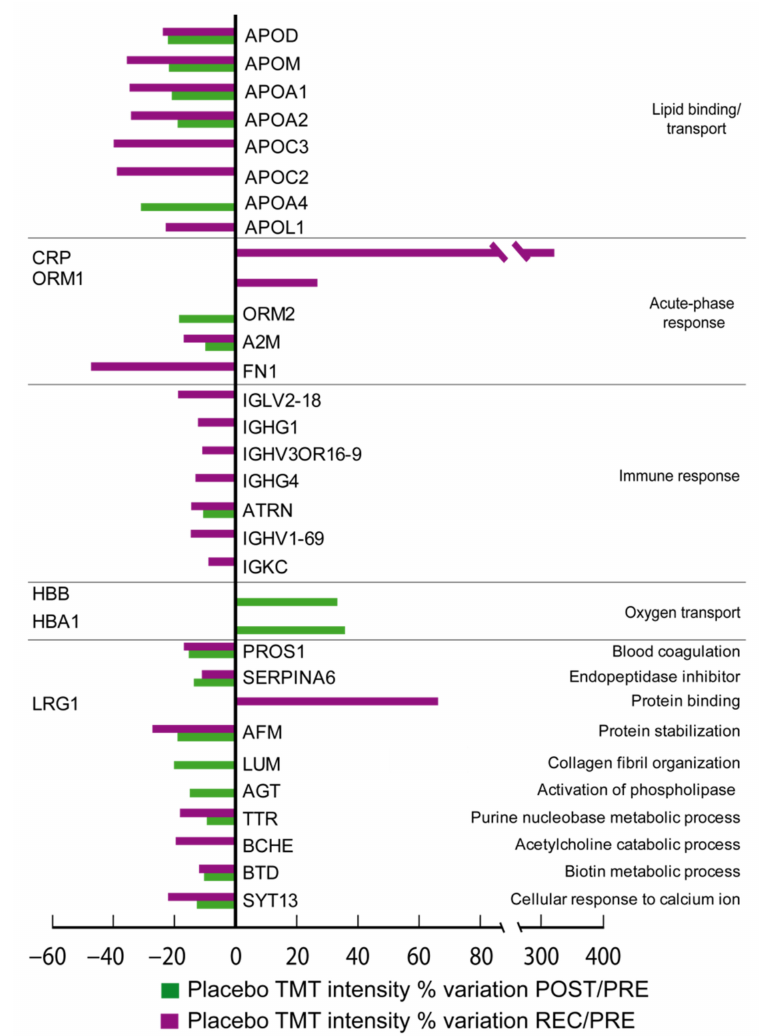
Figure 2. TMT LC-MS/MS proteomic analysis results from sera sample of placebo-treated BR group. Differential abundant proteins are expressed as histograms representing their intensity as a percentage of variation from PRE. Green bars represent variation identified in the POST/PRE, while purple bars represent alterations identified in the REC/PRE comparison. (One-way repeated measures ANOVA and Tukey’s test, n = 5, p -value <